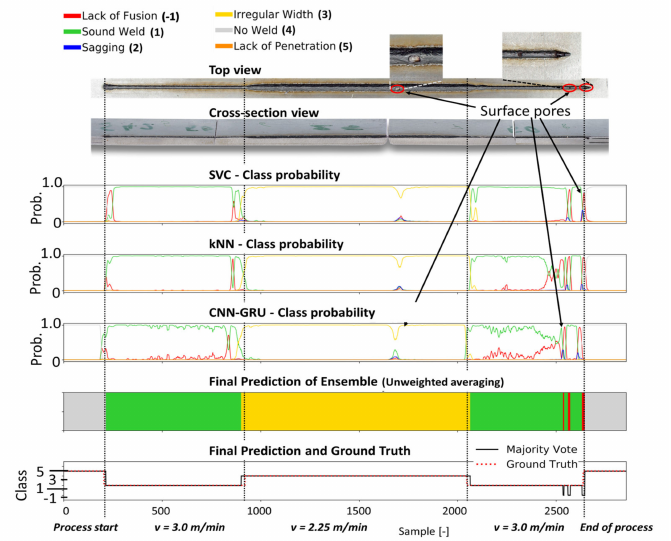
Figure 10. The metallographic characterization, the resulting ground truth data and the classification results for weld 42 based on the proposed ensemble CNN-GRU